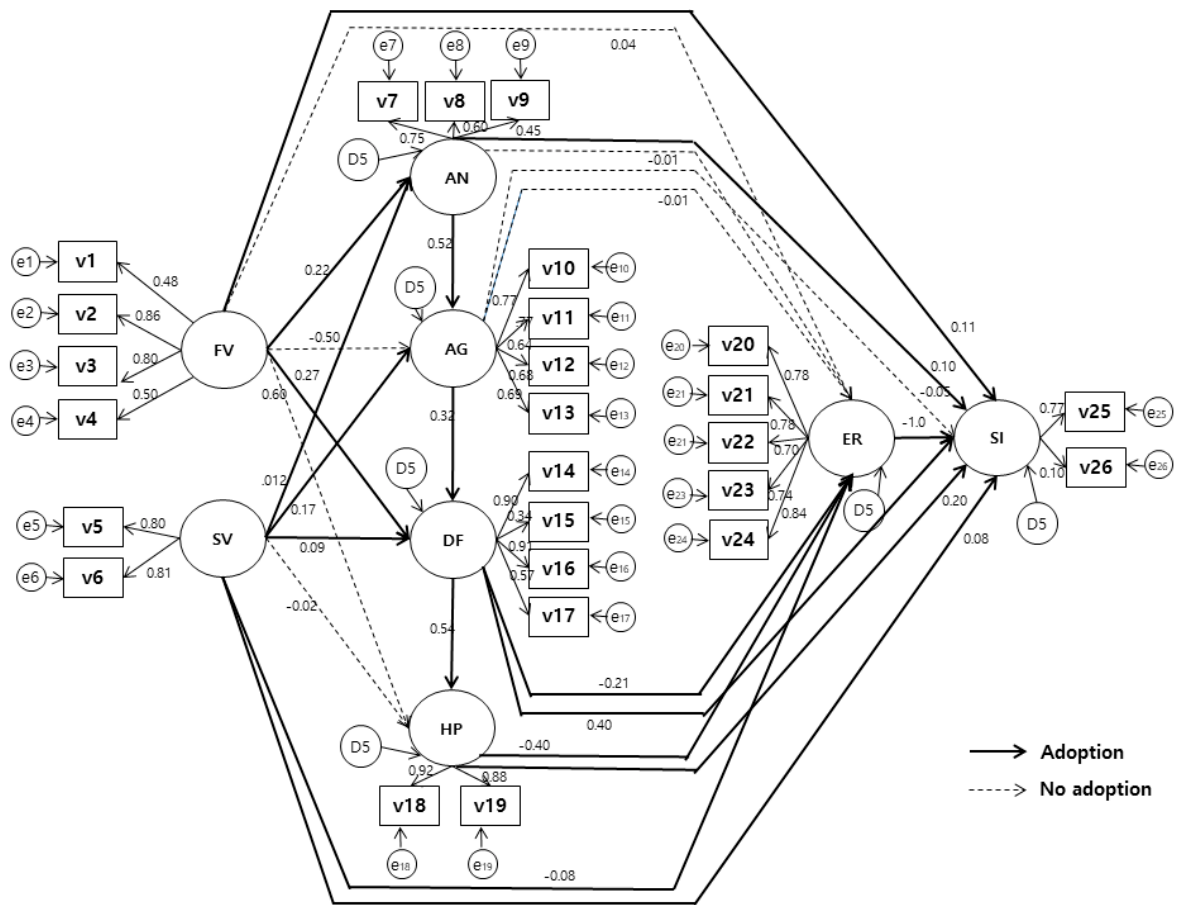
Figure 4. The path diagram of the hypothetical model. FV—Family violence-exposure; SV—School violence-exposure; AN—Anger; AG—Aggression; DF—Depression; HP—Hopelessness; ER—Ego-resilience; SI—Suicidal ideation; V1—Psy-